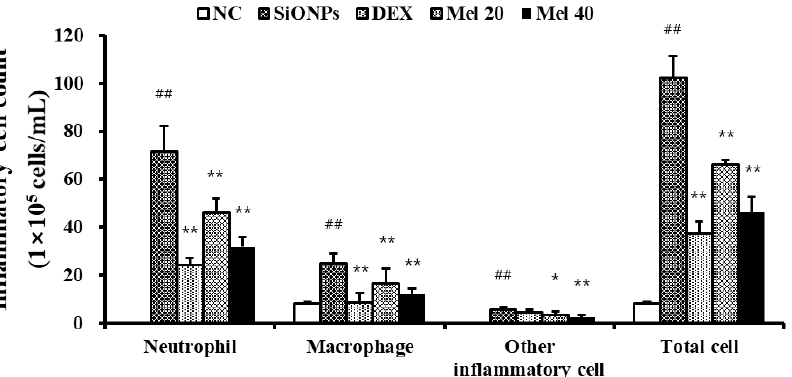
Figure 1. Melatonin decreased inflammatory cell count in SiONPs-exposed mice. Particularly, melatonin reduced the elevated neutrophils and macrophages of BALF in SiONPs-exposed mice. ## p < 0.01, vs. the NC; * p < 0.05, ** p < 0.01, vs. the SiONPs.